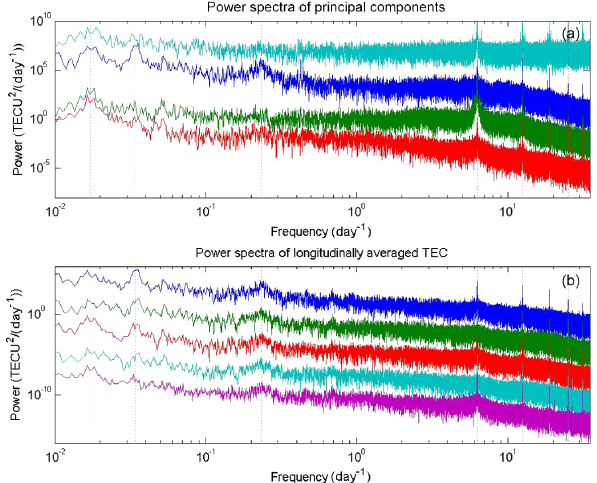
Figure 16. Fourier power spectra of the first four PCs shown in Fig. 13 (panel a ) and the time series at five different latitudes shown in Fig. 14 (panel b ). To avoid clustering, the green and red curves in (a) have been moved down by 3 and 6 orders of magnitude, re- spectively. All the curves except the one at the Equator in (b) have been consecutively shifted downward by 3 orders of magnitude. The cyan curve in panel a denotes the spectrum of the phase 10 4 E phase defined in Eq.